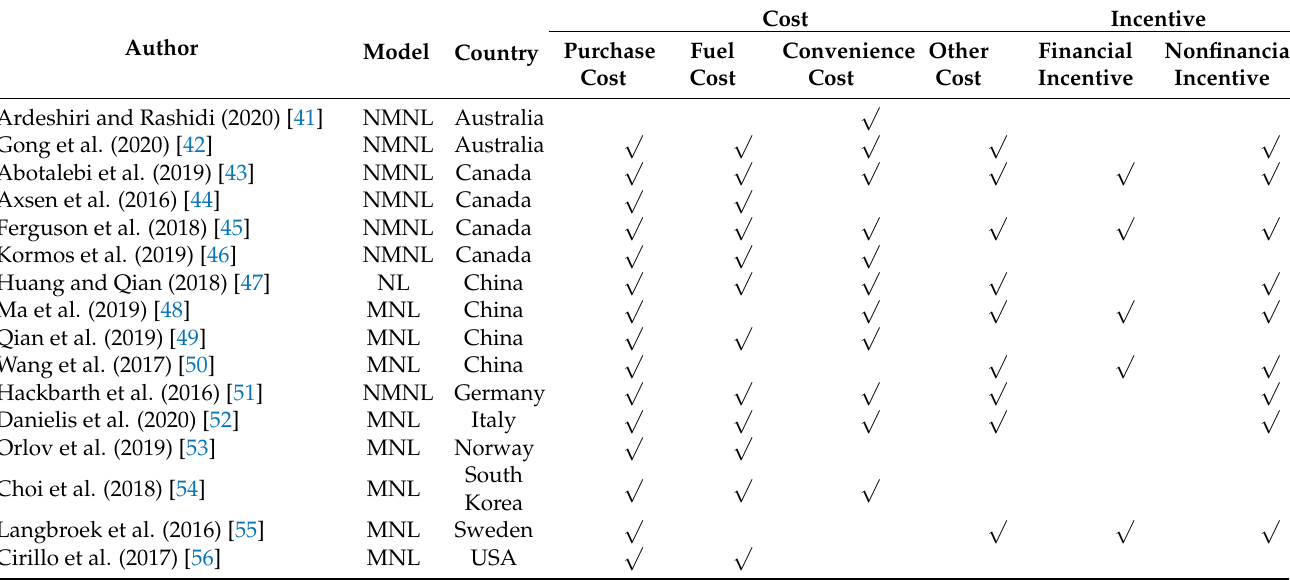
Table 2. Recent studies (2016–2020) on the market diffusion of